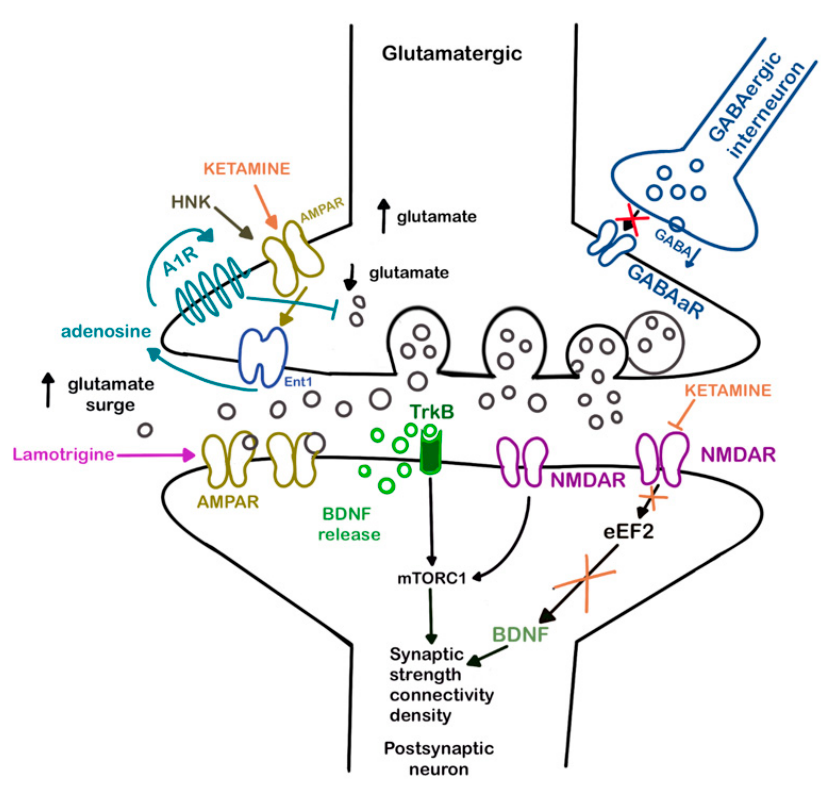
Figure 1. Potential synergistic effect of ketamine and lamotrigine in the treatment of depression. Bipolar disorder (BD) is an impairing and chronic condition with a prevalence